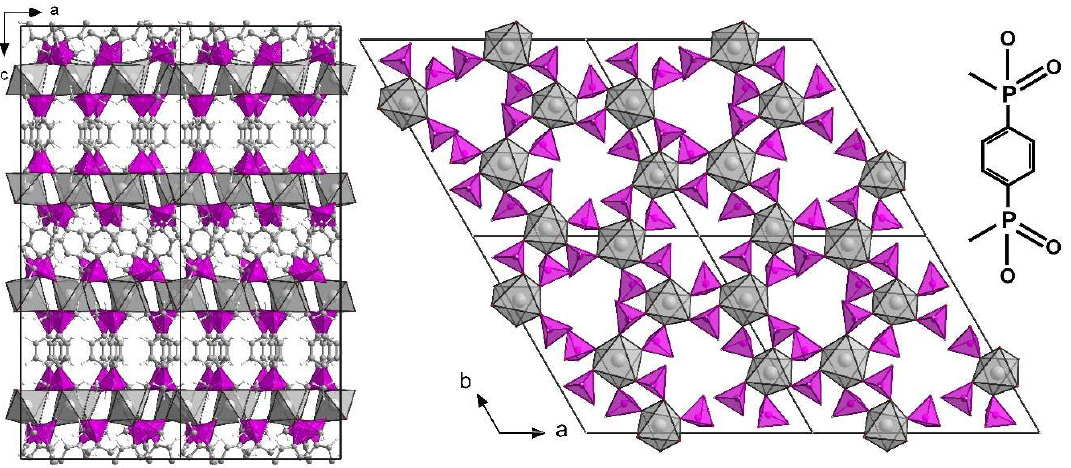
Figure 1. Cluster of 2 × 2 × 1 unit cells of the 2D layer of cerium atoms arranged in the hexagonal honeycomb. The cerium atoms are octahedrally coordinated with oxygen atoms (grey polyhedra) and bound together through O-P-O bridges with phosphorus in a tetrahedral environment (magenta polyhedra). Left is the view along the b direction. Two types of PBP(Me) 2 − bridging rows are clearly visible: (i) phenylene groups are perpendicular to the 2D layers of cerium atoms, (ii) the angles between phenylene groups and the connecting 2D layer are approximately 70 ◦ . Right is the view along the c direction, carbon atoms of phenylene groups and hydrogen atoms were removed for better clarity. The schematic representation of the linker is in the top right corner.